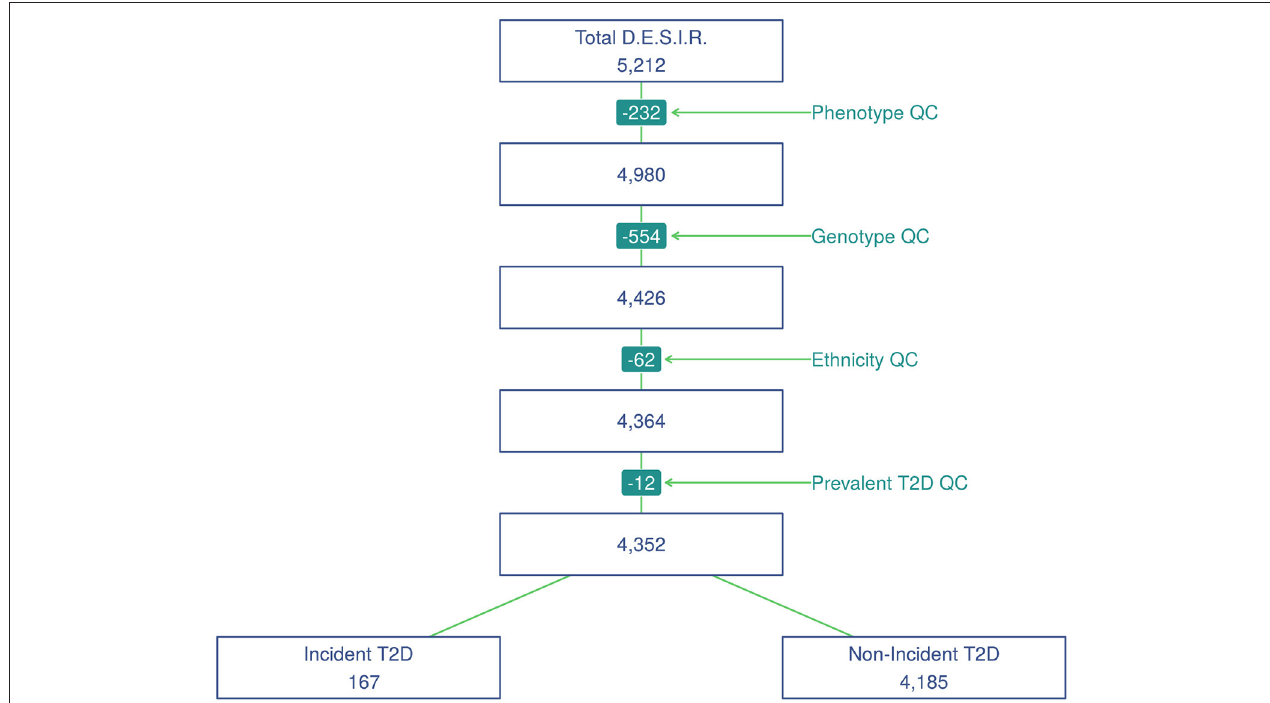
FIGURE 1 | Study flowchart of participants from the French cohort D.E.S.I.R.